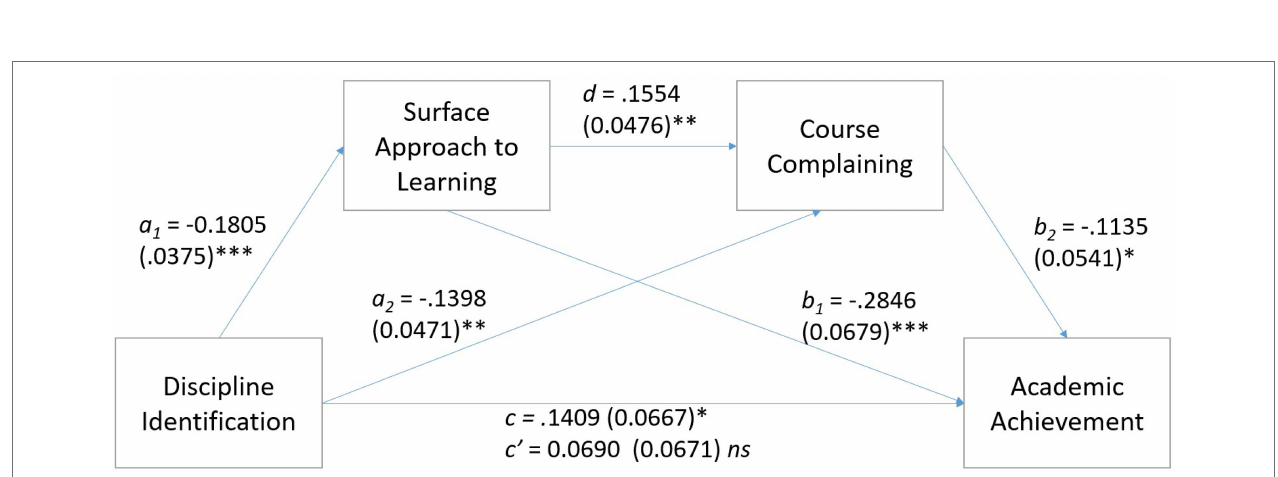
FIGURE 2 | Serial mediation of surface approach to learning and course complaining on the relation between discipline identification and academic achievement (standard errors are shown in parentheses). * p < 0.05, ** p < 0.01, and *** p <